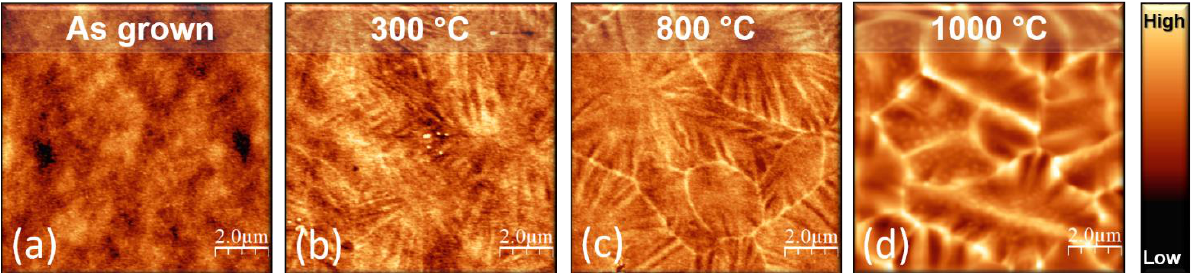
Figure 5. Tapping mode AFM topography, 10 µ m × 10 µ m in size, of TiO 2 64 nm ( a ) as-grown and annealed at ( b ) 300, ( c ) 800, and ( d ) 1000 °C. The color scale ranges from 0 to 6 nm in ( a – c ) and from 0 to 80 nm in ( d ).